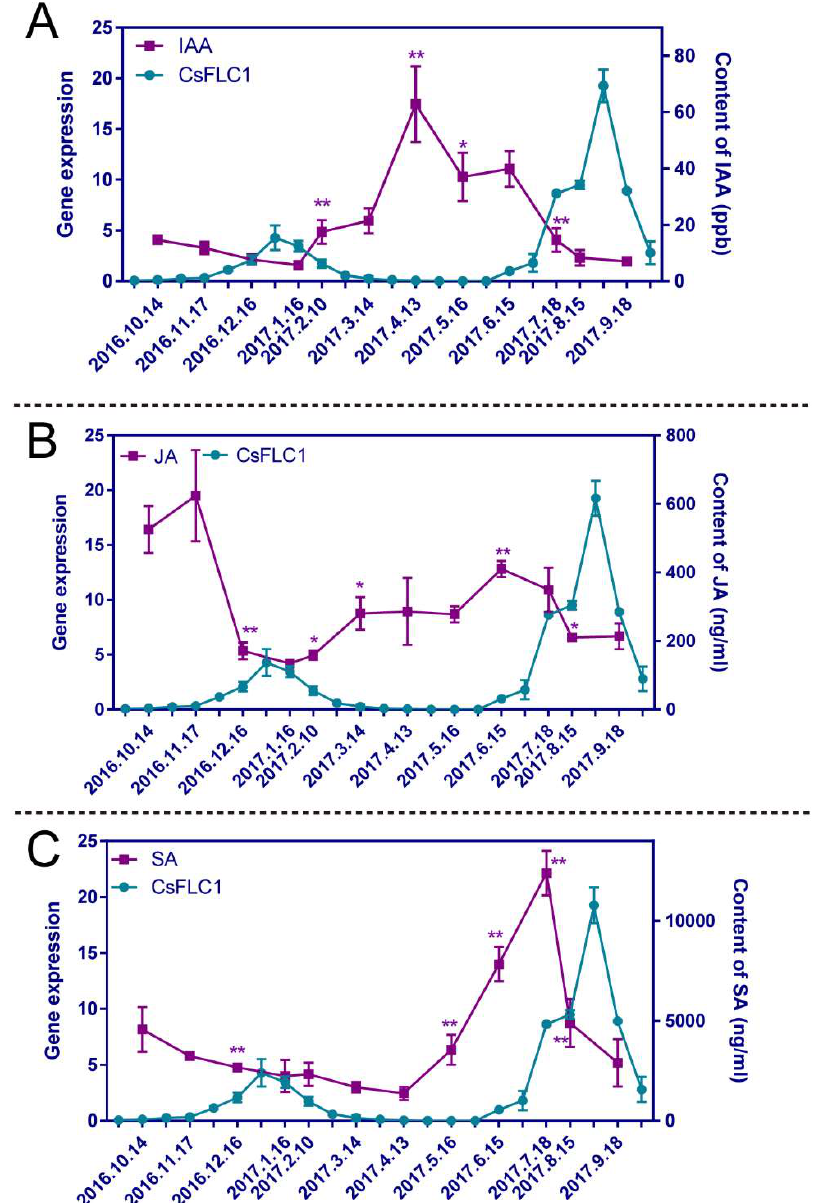
Figure 10. Variation trends of different phytohormone contents in tea plant during the whole year. ( A ) Content of IAA in tea plant throughout the year. ( B ) JA content of tea plant throughout the year. ( C ) Content of SA in tea plant throughout the year. The t-test was applied for difference comparison between measurement data, and each was compared with the previous one; ** represented p < 0.01; * represented p < 0.05. IAA: indole-3-acetic acid; JA: jasmonic acid; SA: salicylic acid.